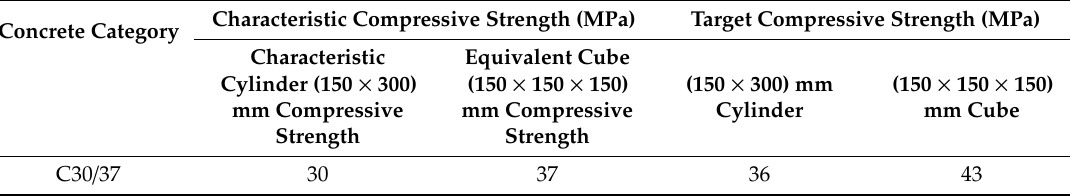
Table 20. Average compressive strengths according to concrete classes.